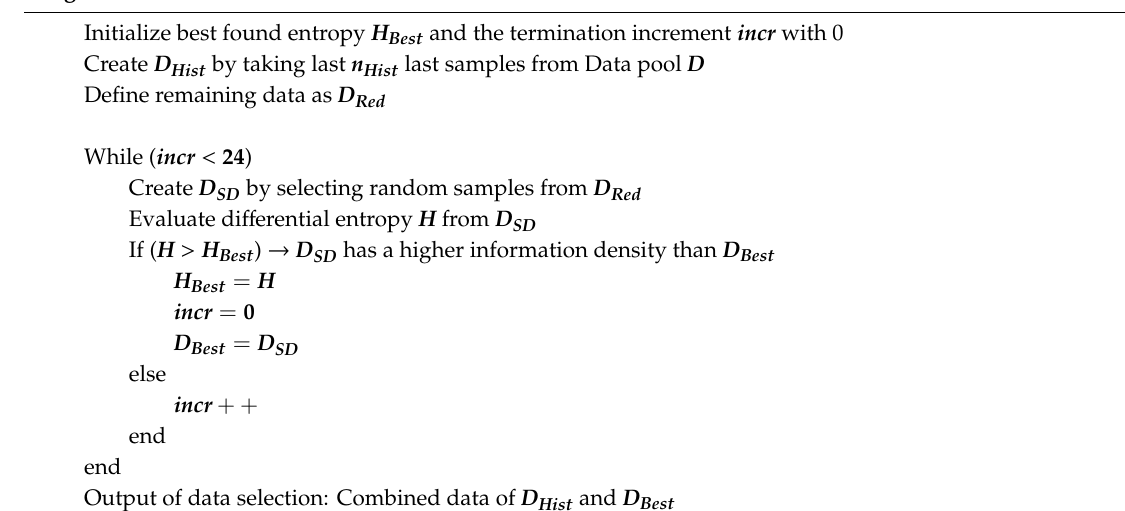
Figure 4 visualizes the data selection: